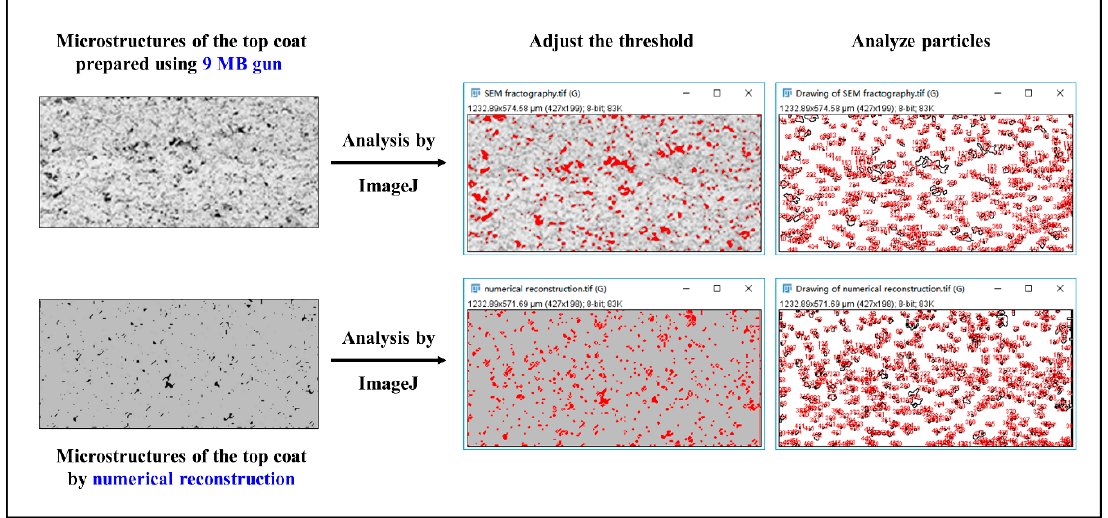
Figure A2. The pore size measurement procedure by ImageJ software. The crack morphologies and sizes were also extracted and chosen from the SEM fractographies of real crack structures.